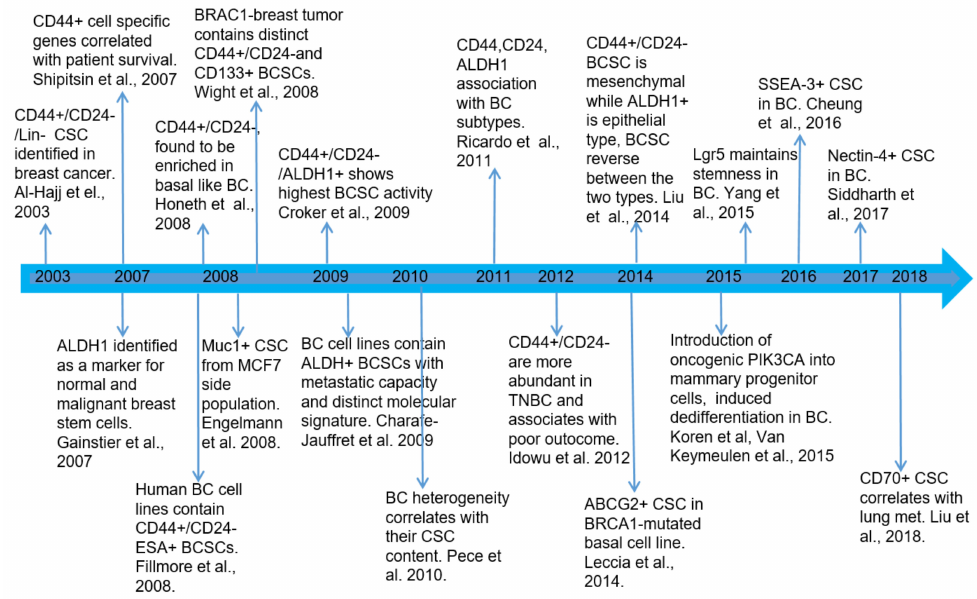
Figure 2. Timeline of important discoveries and findings of breast cancer stem cell studies since the cancer stem cells were initially identified in breast cancer in